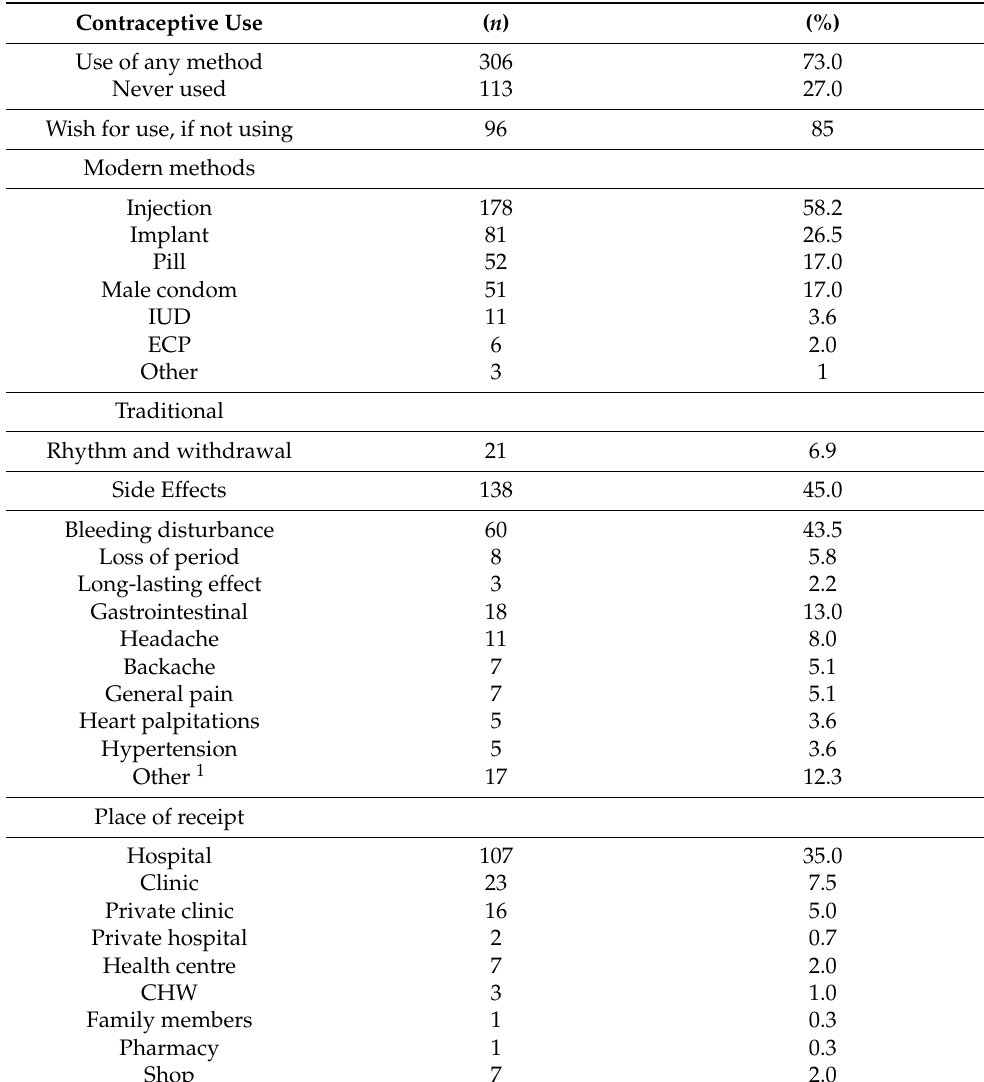
Table 2. Contraceptive use among pregnant women ( n = 419) at three hospitals in southern